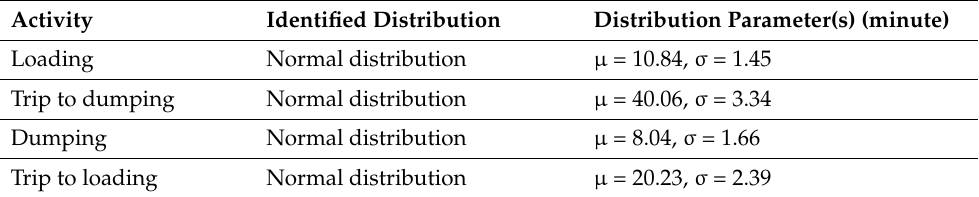
Table 4. Summary of activities’ identified distributions and their respective